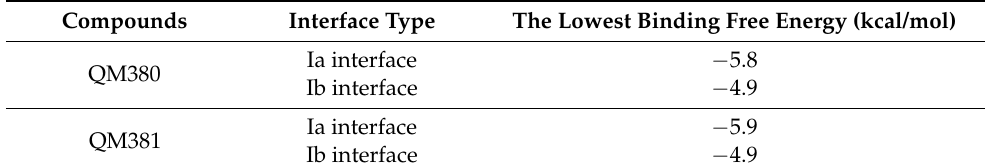
Table 1. The lowest binding free energy (kcal/mol) obtained from docking of two different interfaces of NLRP3 PYD with the most active ligands using the Autodock Vina tool.